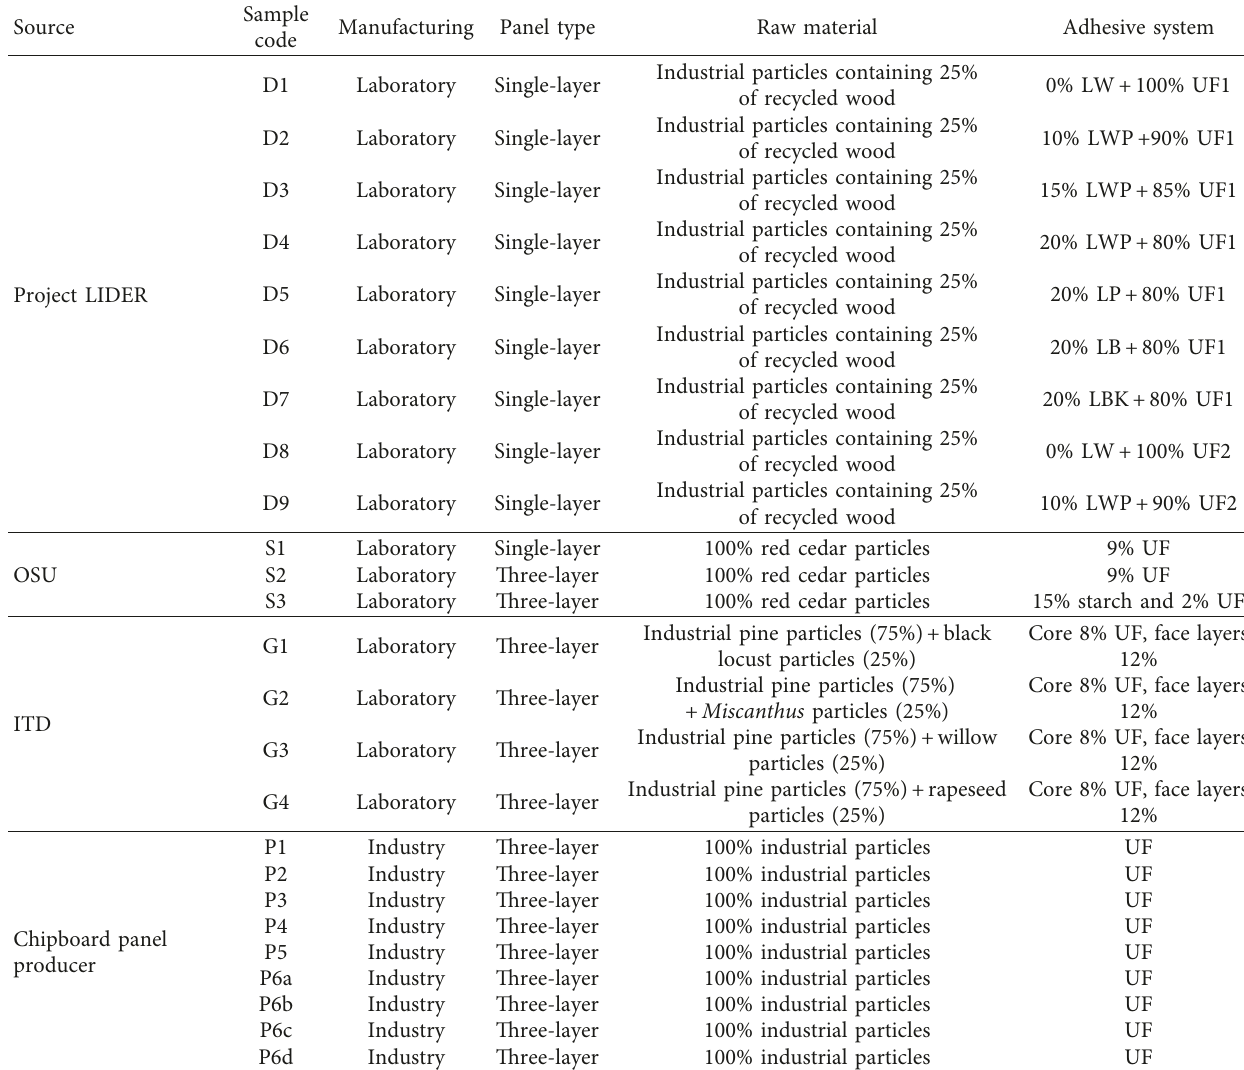
Table 1: Manufactured panels investigated in this